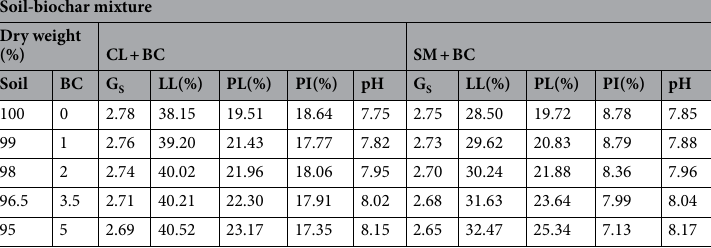
Table 2. The variation of specific gravity and physiochemical properties of soil with the increase in biochar content. BC = biochar, G S = specific gravity, LL = liquid limit, PL = plastic limit, PI = Plasticity